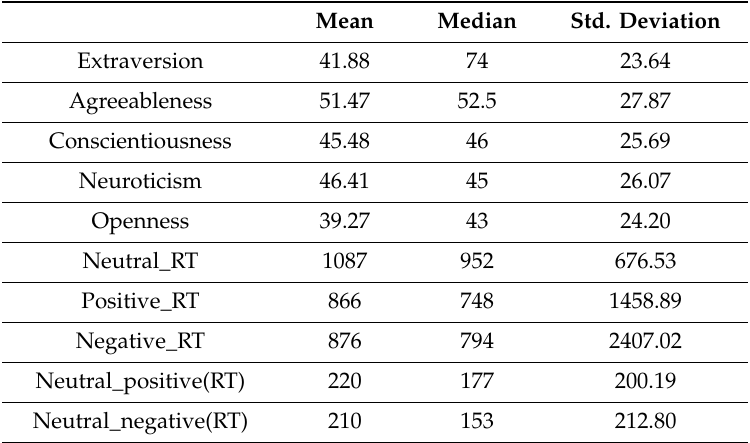
Table A2. Mean, median, and standard deviation of measuring variables.